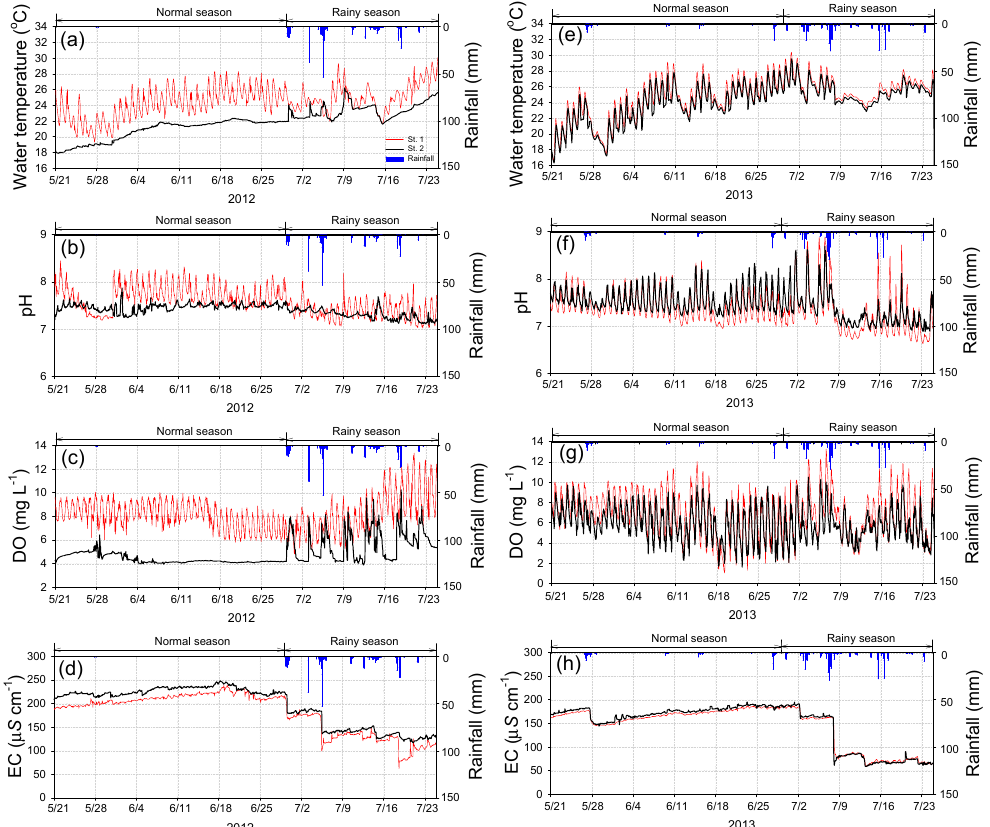
Figure 3. Variations in the water temperature, pH, DO, and EC values of St. 1 and St. 2 during the normal and rainy seasons under stagnant ( a – d ; 2012) and circulation ( e – h ; 2013) conditions. The water depth kept constant, regardless of time order, and the maximum water depth was 0.69 ± 0.01 m in 2012 and 0.69 ± 0.03 m in 2013 ( n = 7).